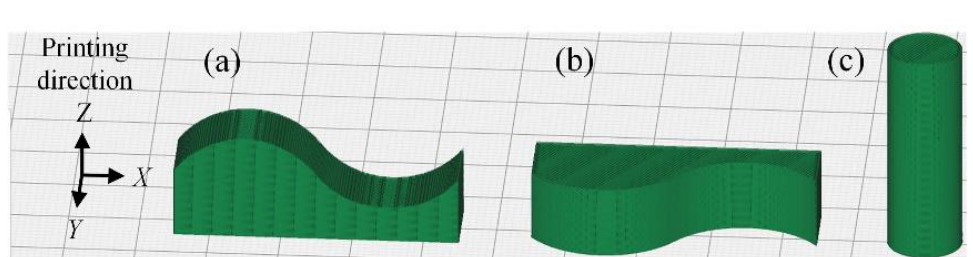
Figure 1. Printing of specimens: ( a ) 0° printing of curved specimens; ( b ) 90° printing of curved specimens; ( c ) shear test specimens. Table 2. AM process